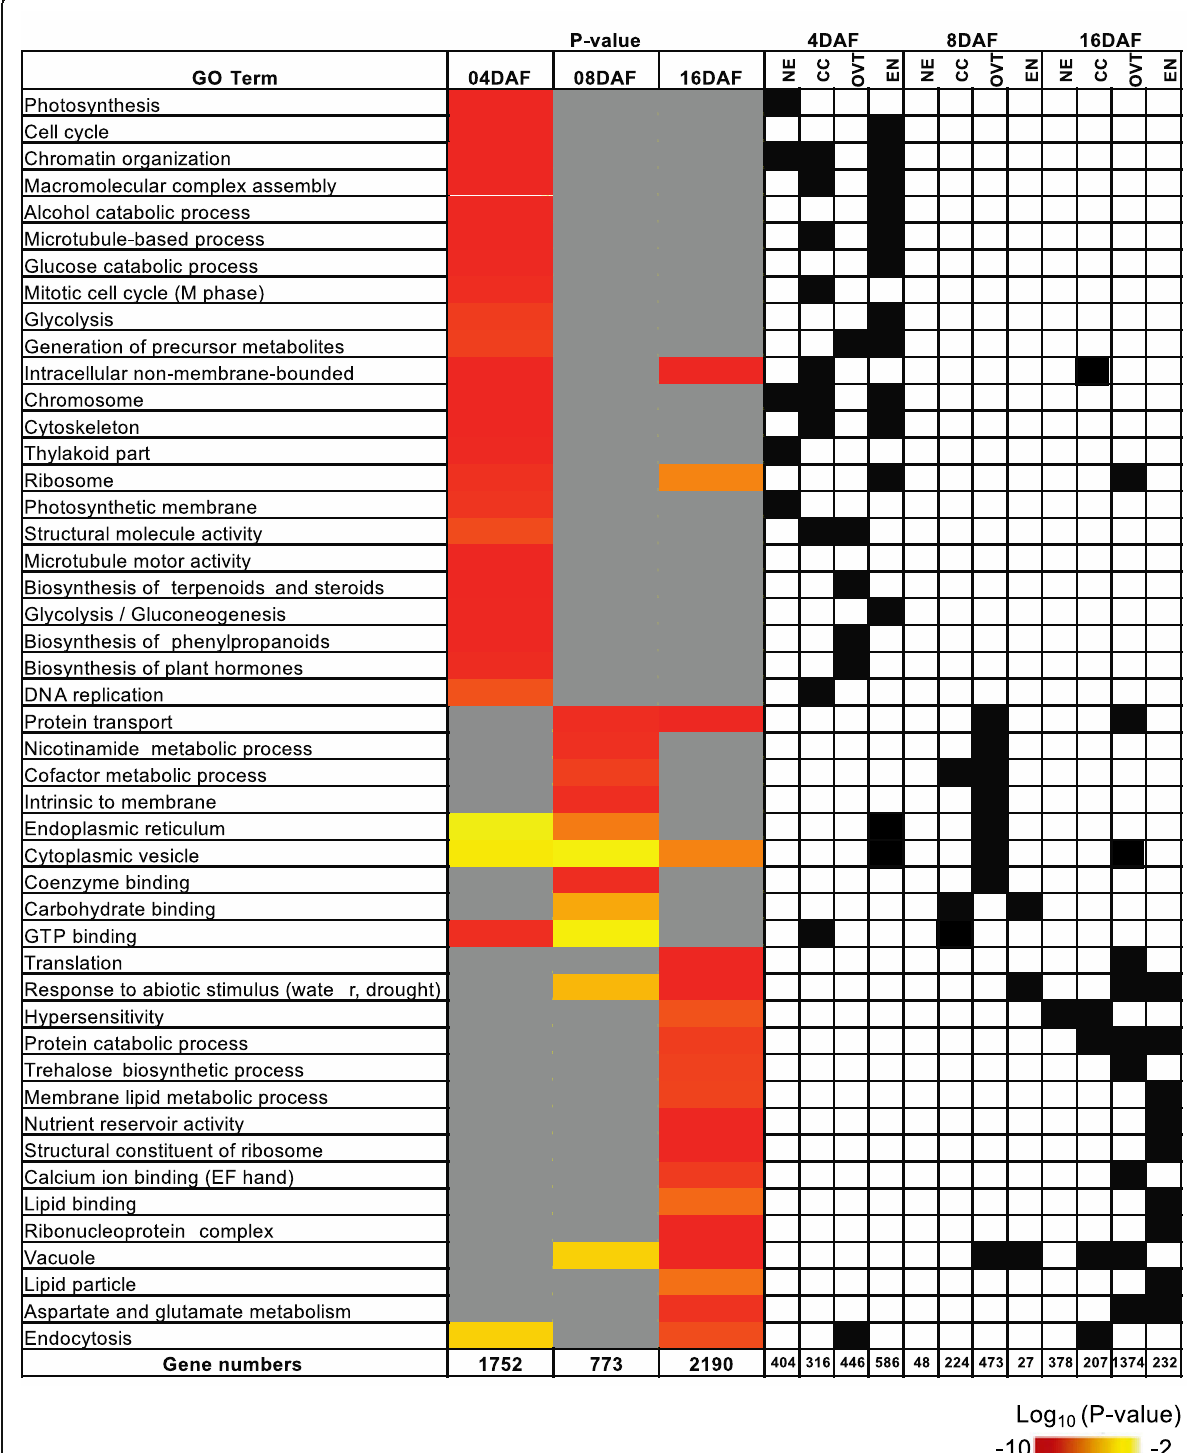
Fig. 3 GO analysis of the DEGs in the developing rice grain at 4, 8 and 16 DAF. GO terms from biological process are shown. Significantly (p < 0.01) overrepresented GO terms at 4, 8 and 16 days after flowering (DAF) are shown as heatmap. Color key represents Log 10 (P-value). Black boxes in the right panel indicate the specific tissues with the enriched GO terms. If a certain GO term was not significantly enriched (P-value > 0.01) in a certain tissue or stage, the cell is colored